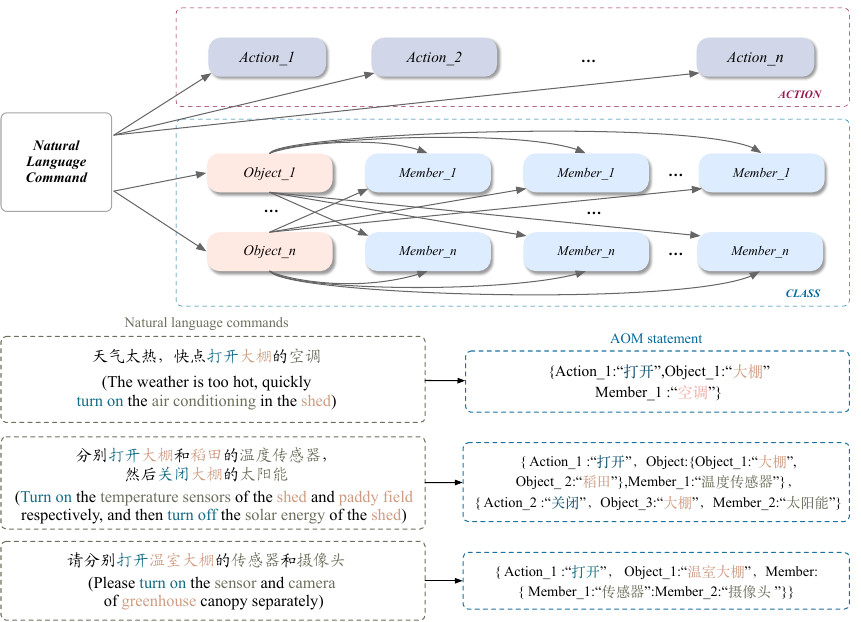
Figure 2. Sketch of a language storage framework based on dynamic tuple extraction and NL2AOM